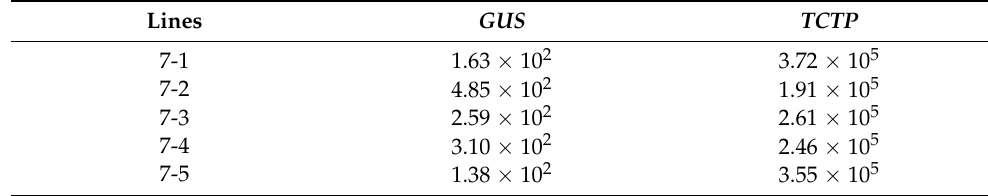
Table 4. Transcript abundance of GUS , TCTP by qRT-PCR in stably transformed lines.